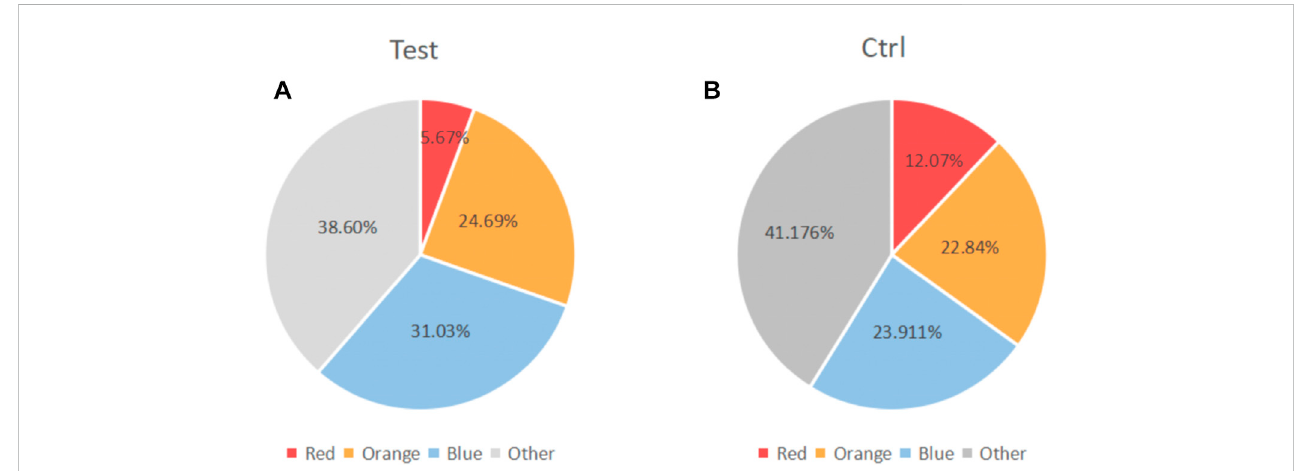
FIGURE 8 Changes in the proportion of microbiota complexes after adjuvant systemic antibiotics usage. (A) Experimental group. (B) Control group.Red part: red complex(including Porphyromonas.Gingivalis,Tannerellaforsythia, and Treponemadenticola ).Orangepart:Orangecomplex.Bluepart,bluecomplex.Grey part, Other